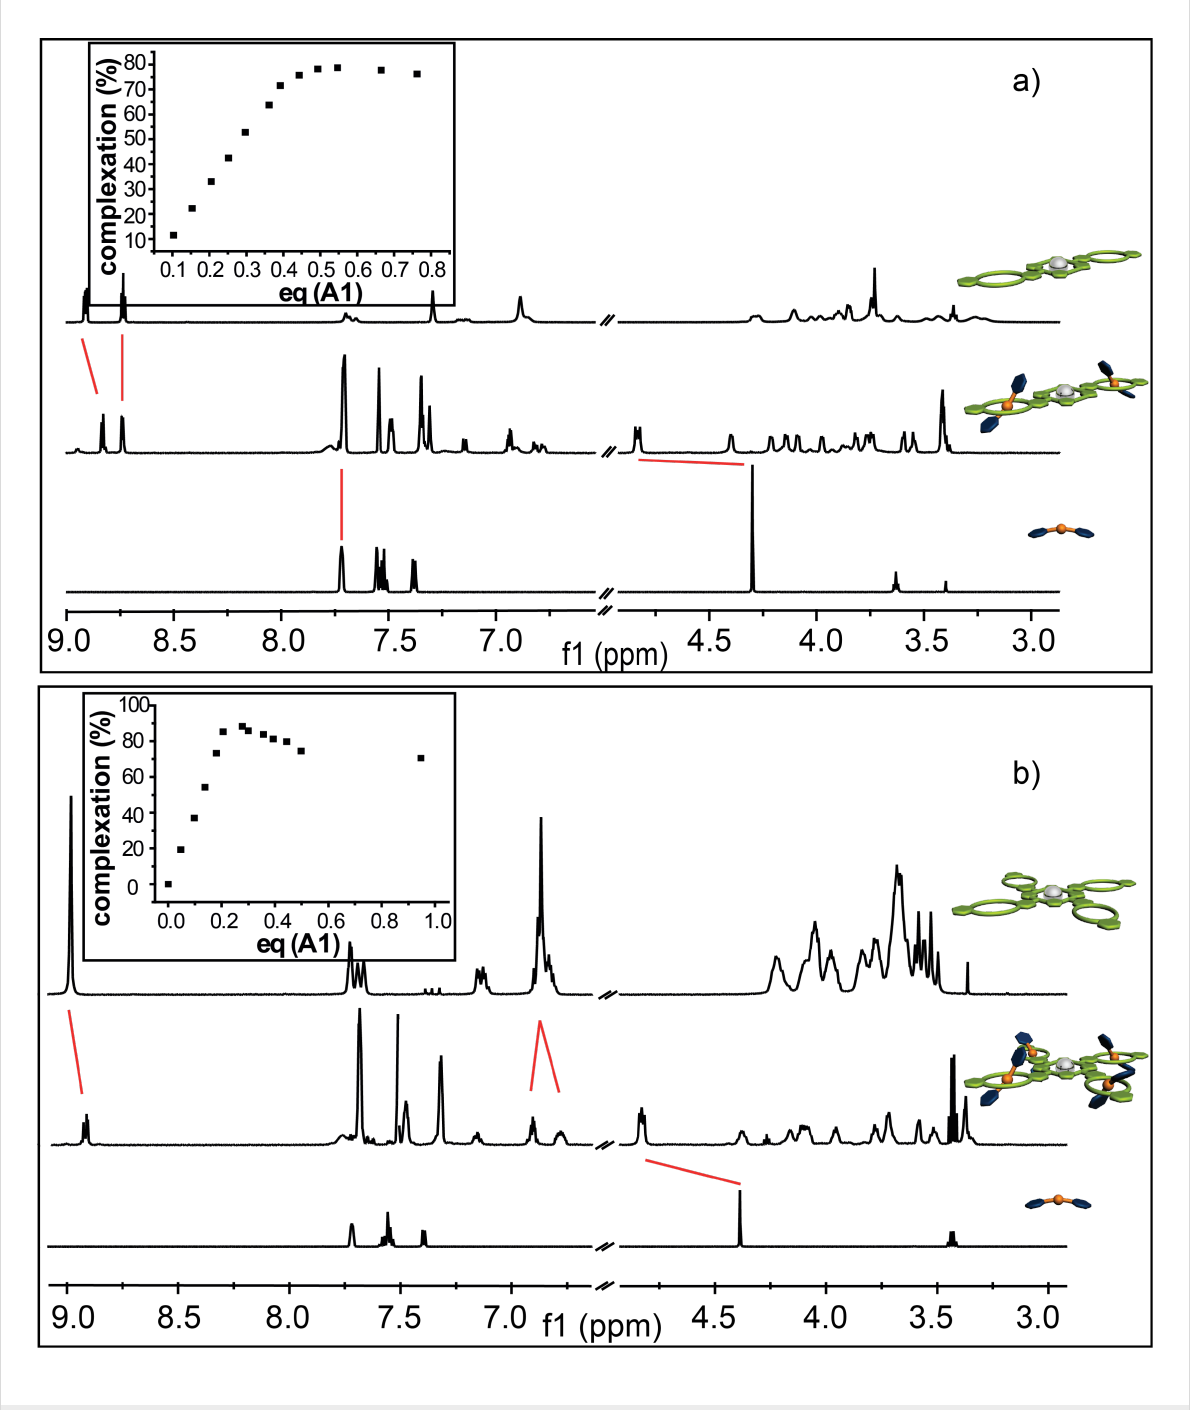
Figure 4: 1 H NMR (500 MHz, 298 K, CD 2 Cl 2 , 3 mM) of a) C2 (top), A1 2 @ C2 (middle) and A1 (bottom) and b) C4 (top), A1 4 @ C4 (middle) and A1 (bottom) showing clear evidence of the complexation. The red lines indicate the shift of the proton signals upon addition. The inserts show the titra- tion curve of each complexation with the expected ratio of the complex formed.